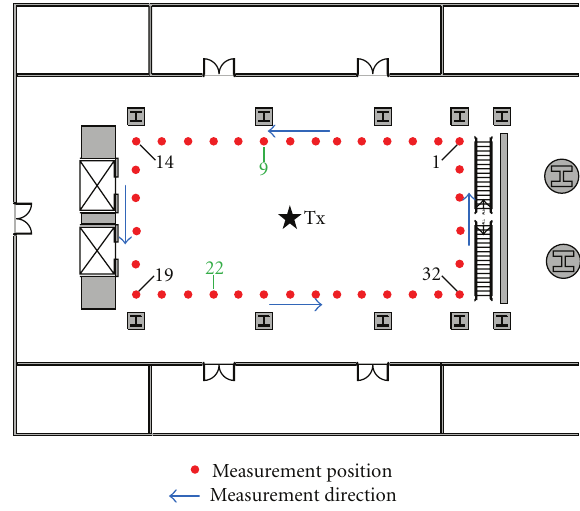
Figure 1: The setup of the MIMO channel measurement system.